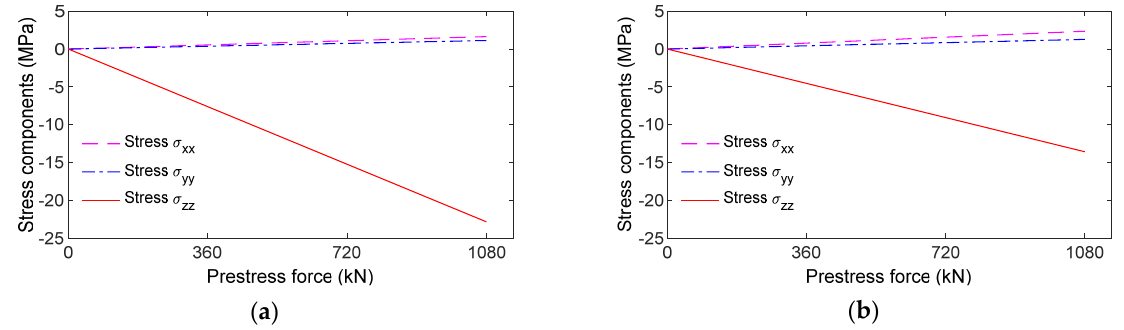
Figure 2. Stress distribution in prestressed anchorage zone subjected to applied force, PS: ( a ) von Mises stress; ( b ) Axial stress.